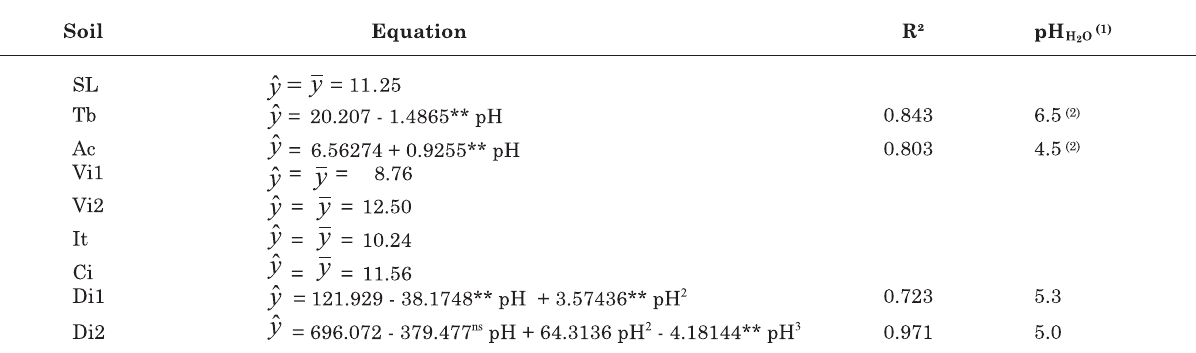
Table 3. Regression equations adjusted for dry matter production (g/pot) of the sorghum shoots as a variable of the pH H O of soil incubated with triple superphosphate incubation 2